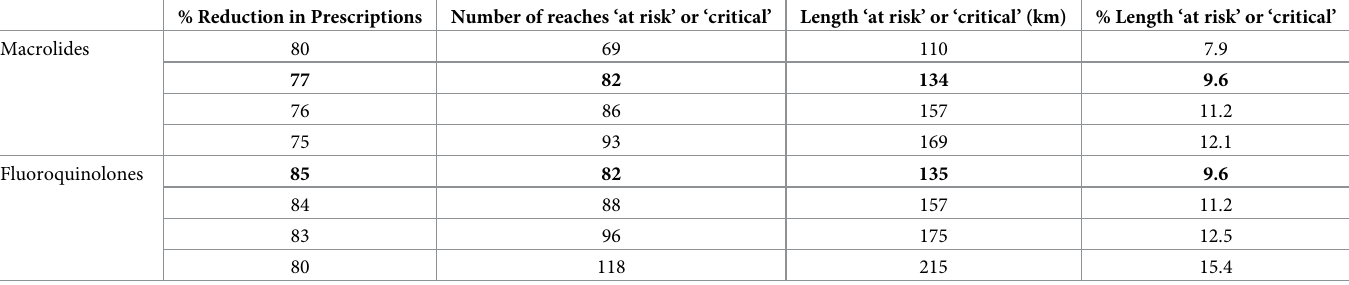
Table 8. Sensitivity analysis for the level of reduction in prescriptions needed to protect 90+% of the length of the modelled River Thames catchment from resis- tance gene selection. % Reduction in Prescriptions Number of reaches ‘at risk’ or ‘critical’ Length ‘at risk’ or ‘critical’ (km) % Length ‘at risk’ or ‘critical’